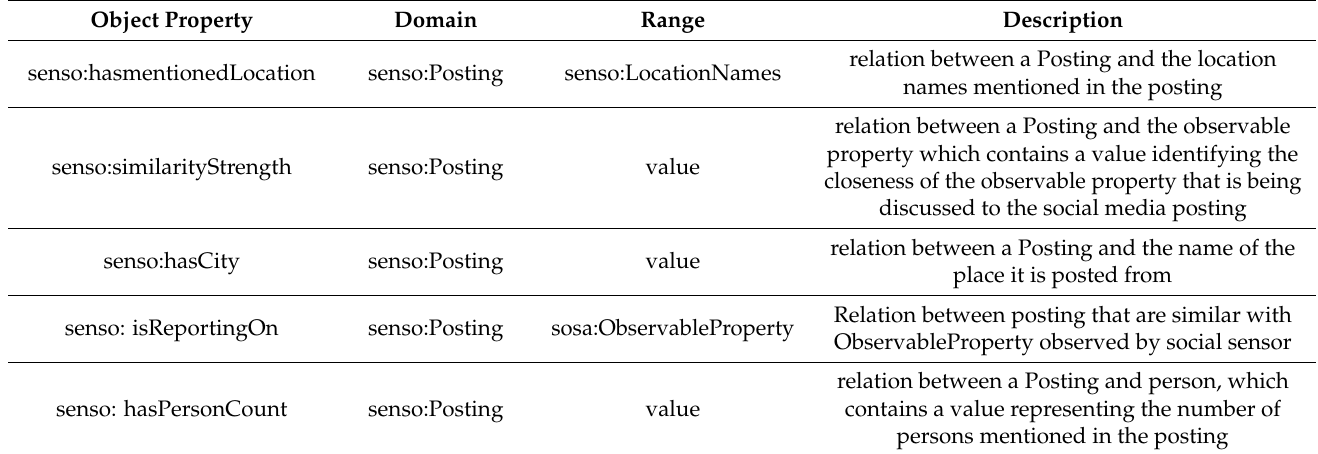
Figure 4. Top situation model classes for mapping social media postings. Table 4. The main object properties, corresponding domain, range, and the description.